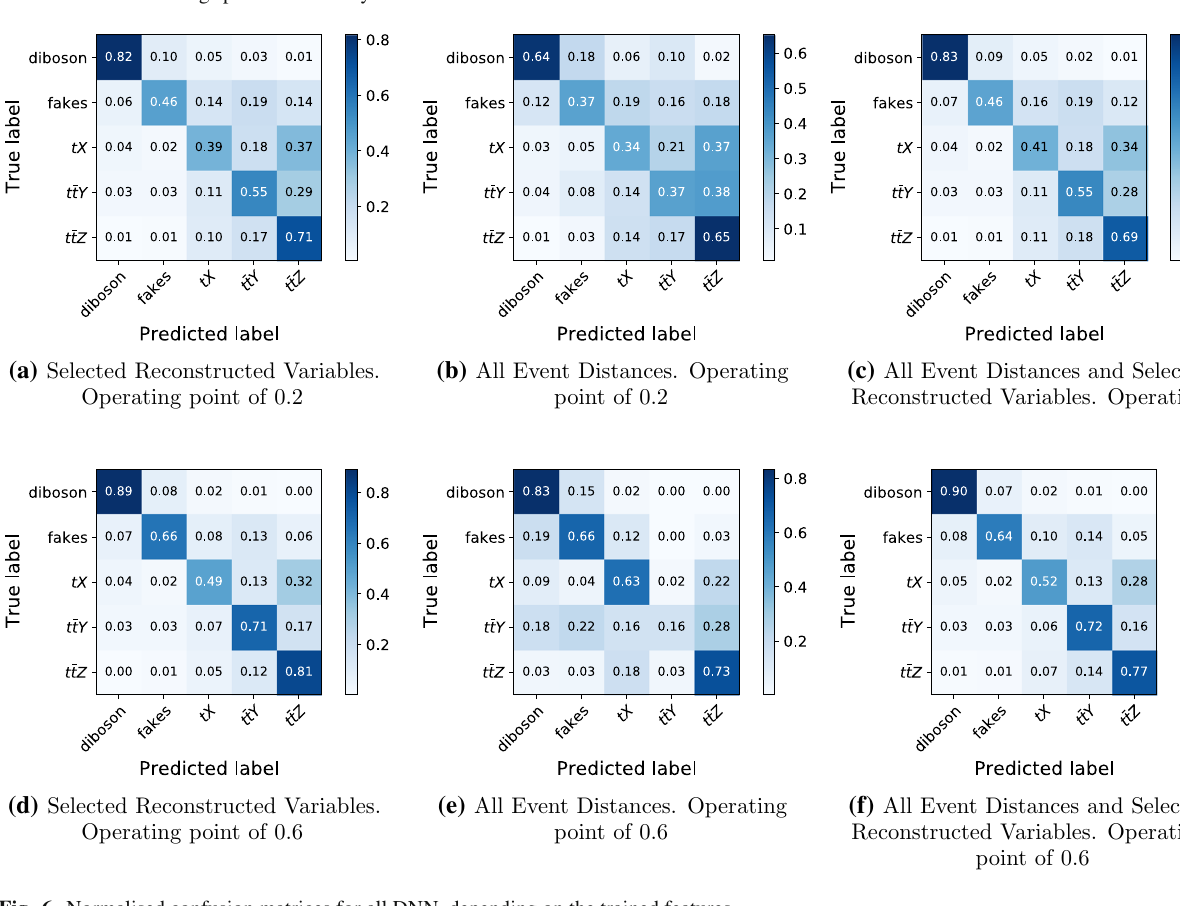
hyperparameters were fixed using HyperBand [29] as imple- mented by Keras–Tuner [30] for each set of features. The hyperparameteres tuned by the HyperBand algorithm were the number of layers (from 1 to 10), the number of units per layer (from 8 to 512 in steps of 8), dropout rate (from 0 to